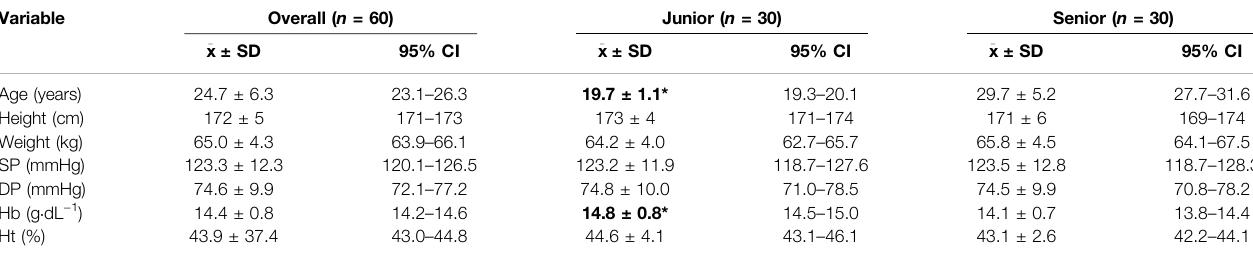
TABLE 1 | Participants ’ characteristics — overall and both groups.